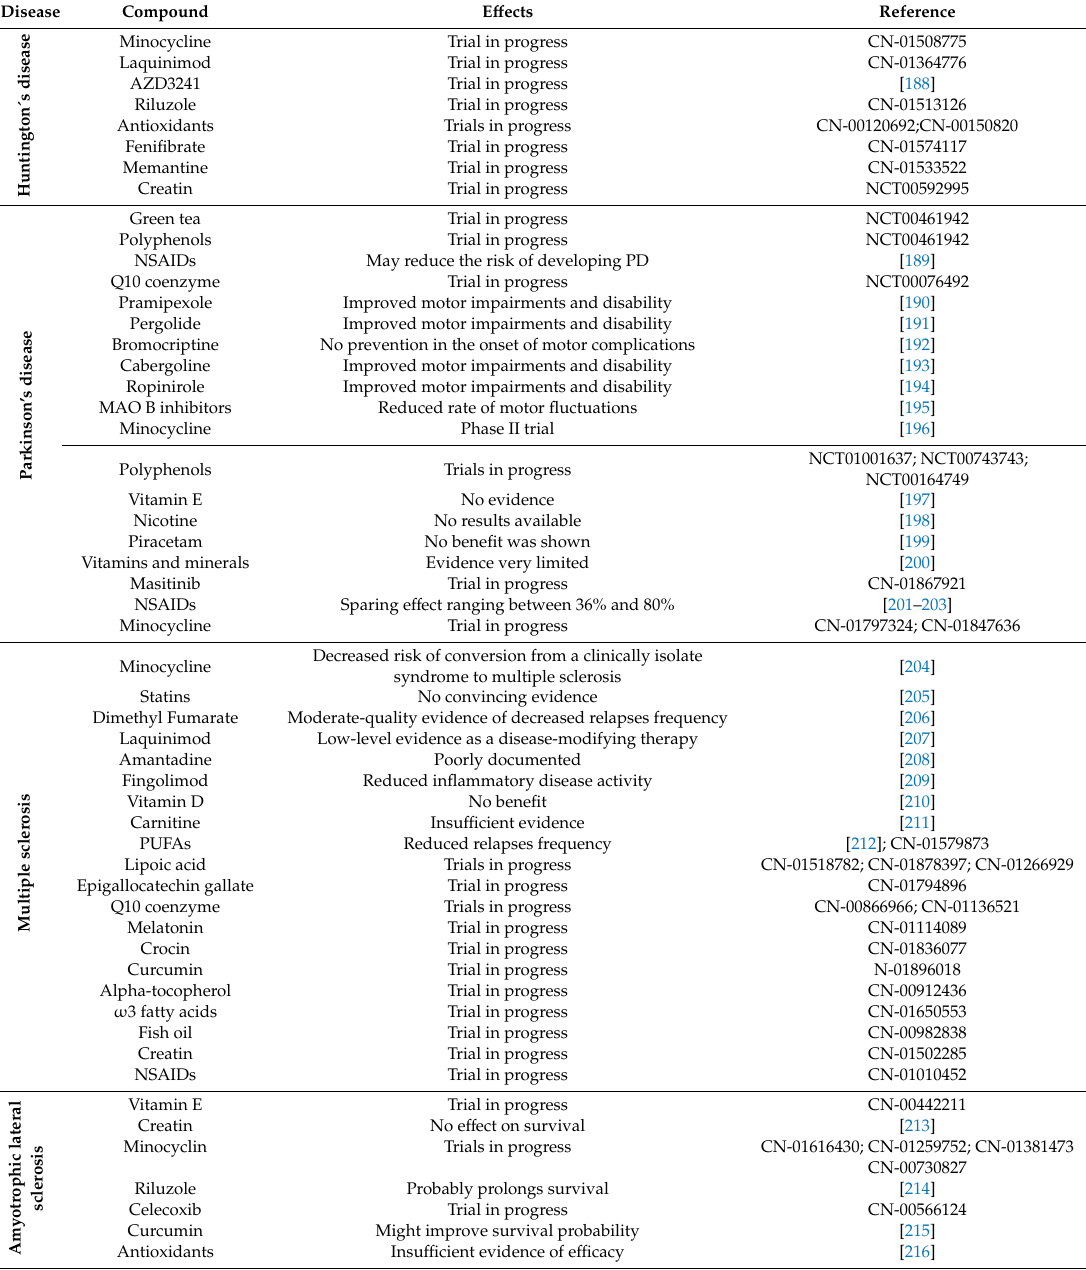
Table 1. Clinical trials using anti-inflammatory / antioxidant drugs for the prevention or improvement of neurodegenerative diseases.